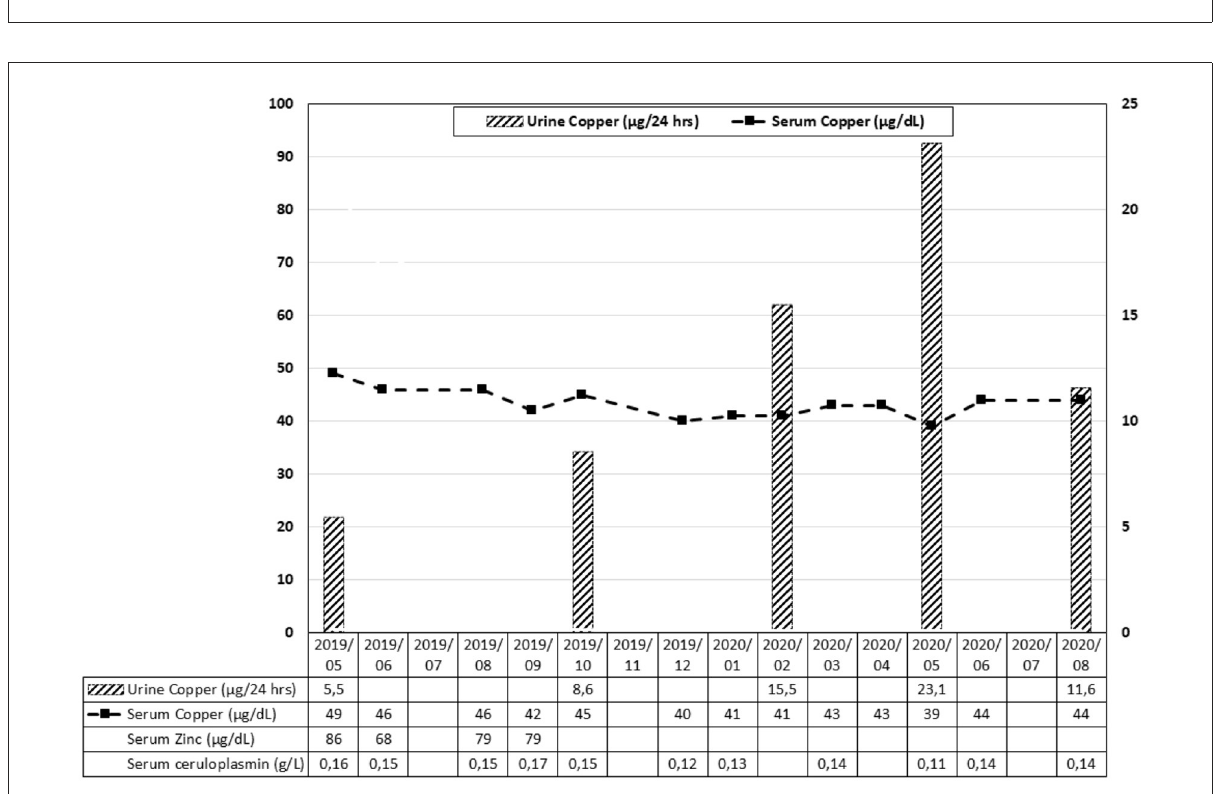
FIGURE3 Evolution of serum copper, zinc, ceruloplasmin, and urine copper over time. The corresponding dosage regimen of copper supplementation is mentioned in the text.